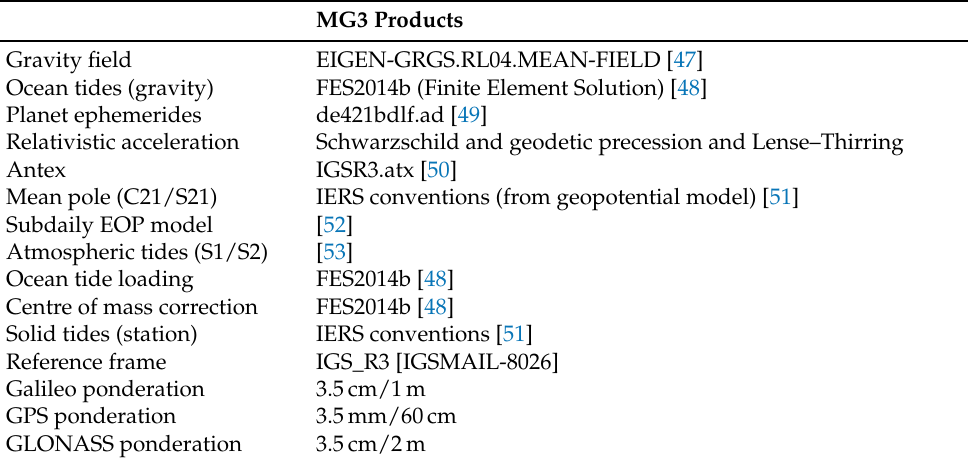
Table 1. Dynamical and loading models used for MG3